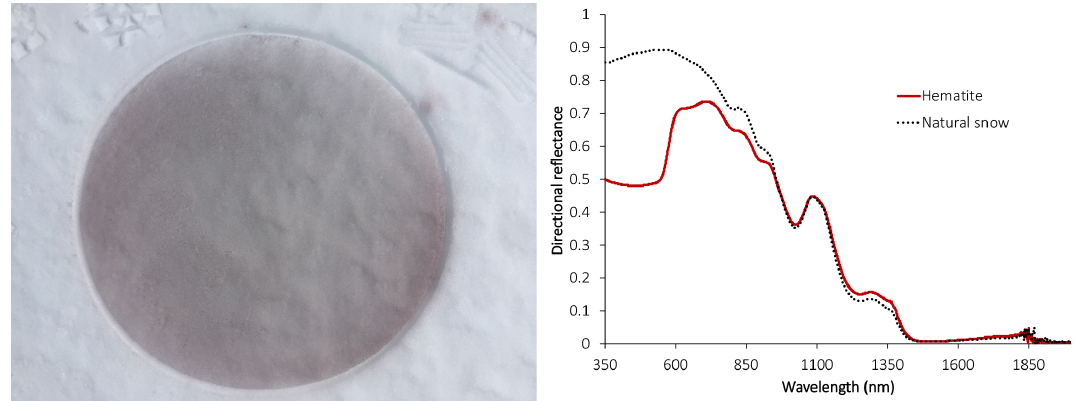
Figure 7. Image and HCRF spectra for a hematite deposition and adjacent natural snow in May 2016 at the CUES research site. This hematite deposition drastically reduced the high natural snow reflectivity in the ultraviolet and short-wavelength visible (<600nm) spectral regions. Solar zenith: 21.5 ◦ ; solar azimuth: 154.3 ◦